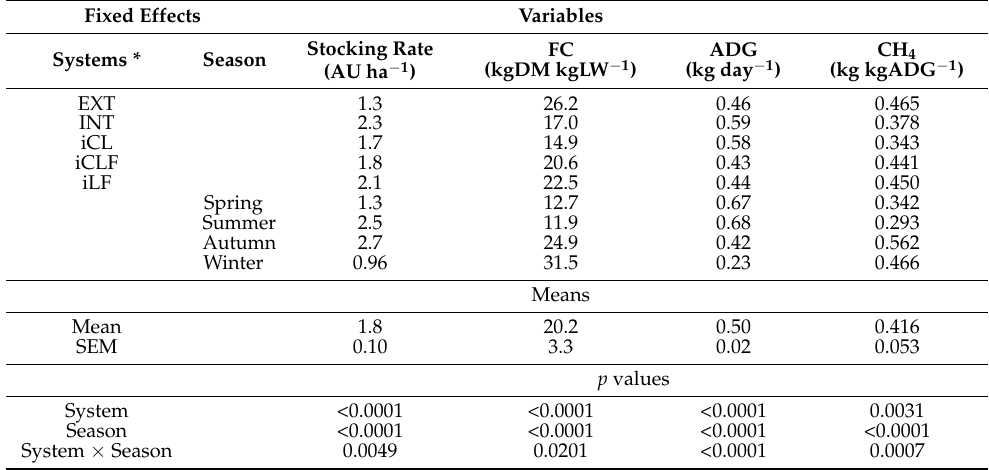
Table 5. Animal stocking rate, feed conversion, average daily gain and CH 4 emissions per kg of ADG of cattle raised in different pasture production systems in Brazil southeast (means of two